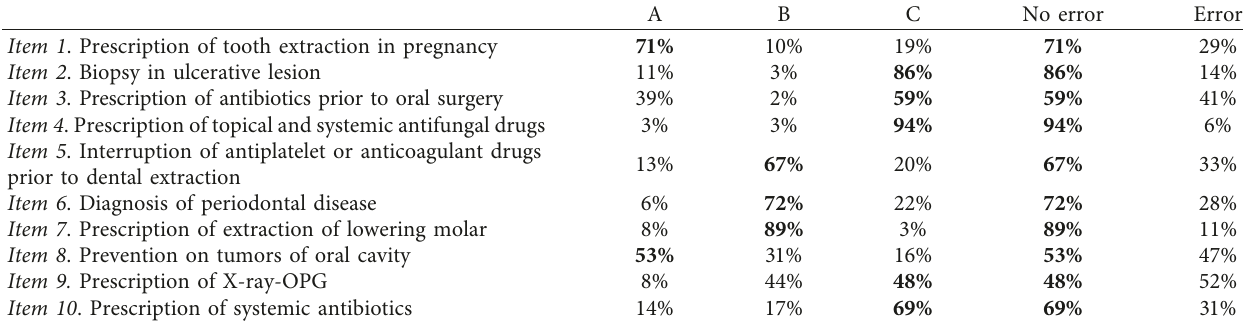
Table 3: Percentage frequency of answer for each item (the correct one is in bold) and of correct/not-correct answers for each items.